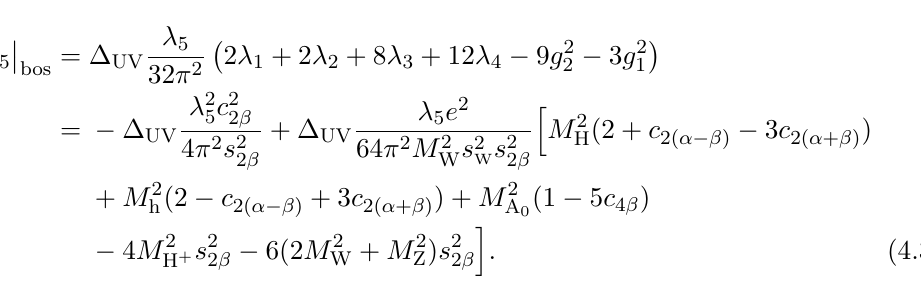
Figure 3 . Generic diagrams contributing to the HA ization of (cid:21) 5